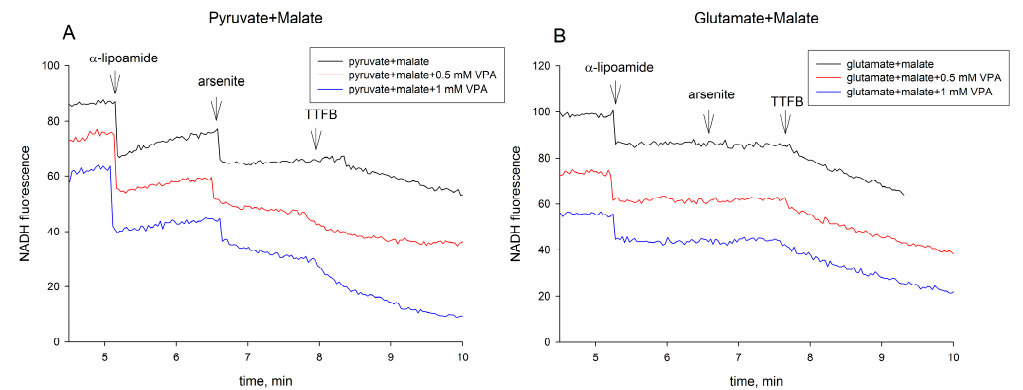
Figure 5. Effect of VPA on pyruvate ( A ) and glutamate ( B ) dependent arsenite-sensitive re-reduction of NAD(P) + by α -lipoamide dehydrogenase. Representative experimental traces of mitochondrial NAD(P)H fluorescence showing re-reduction of NAD(P) + after α -lipoamide (75 µM) additions (first arrow). α -Lipoamide dehydrogenase is blocked by addition of 10 mM arsenite (second arrow). Finally, the uncoupler 4,5,6,7-tetrachloro-2-trifluoromethyl benzimidazole (TTFB, third arrow) was added. The detailed experimental conditions are described in the Materials and Methods section.